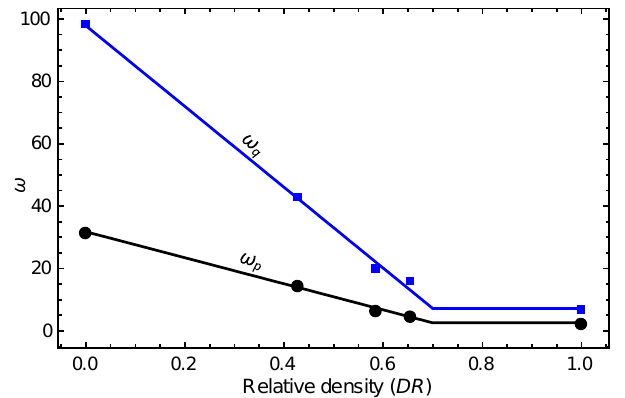
Figure 5. Stress relaxation coefficients as a function of the relative density (dots = DEM simulations, lines = suggested